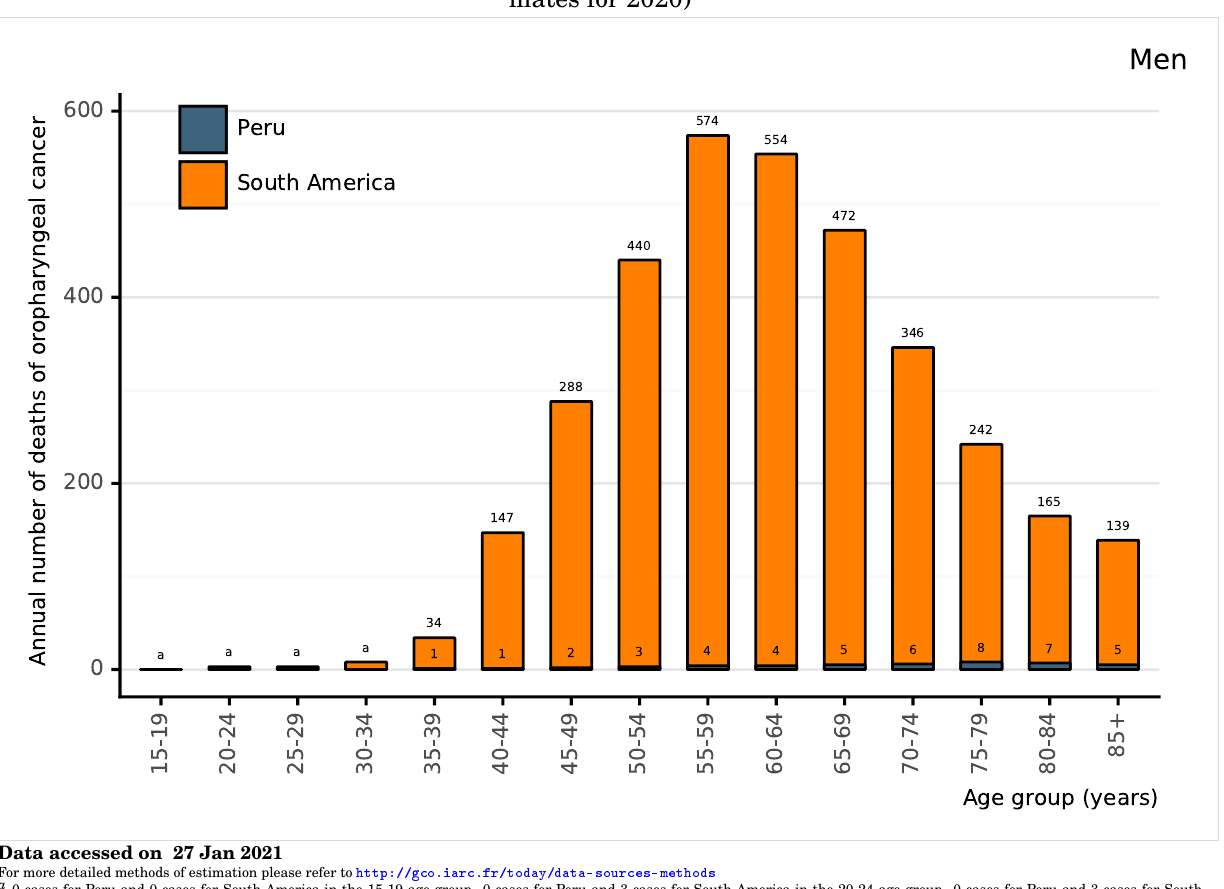
Figure 123: Annual number of deaths of oropharyngeal cancer among men by age group in Peru